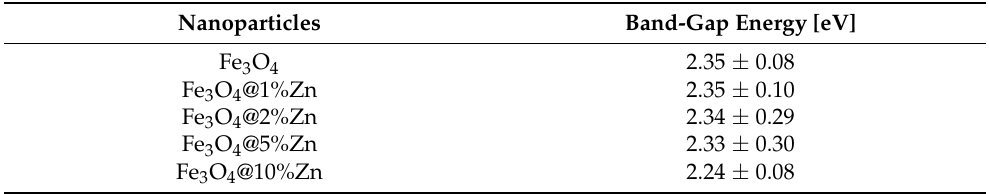
Table 3. Band-gap value for samples with different concentration of zinc in the crystal structure of nanoparticles measured three times for each sample type.